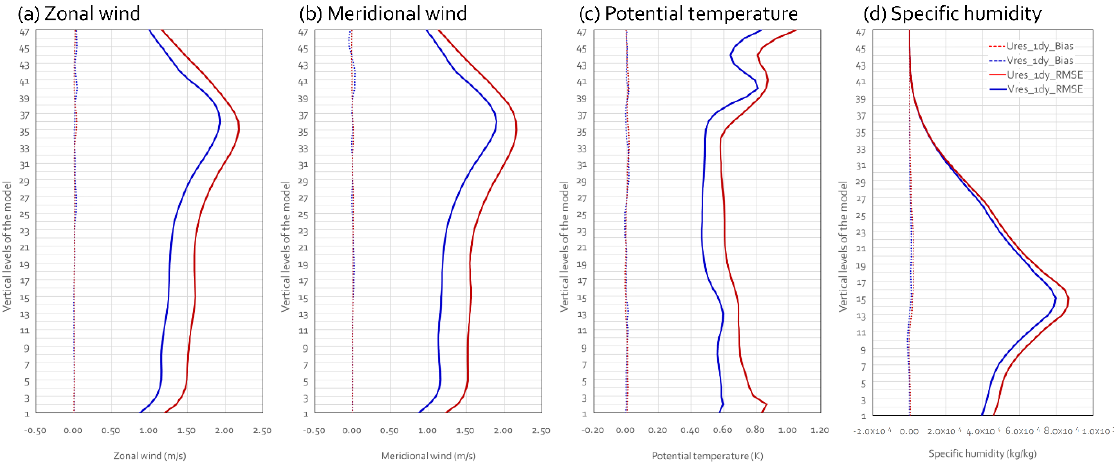
Figure 9. Vertical profile of averaged RMS difference (solid lines) and bias (dashed lines) between the mean BV and the nature of ( a ) zonal wind, ( b ) meridional wind, ( c ) potential temperature, and ( d ) specific humidity. Here, red lines indicate results from Ures_6hr and blue lines indicate results from Vres_6hr.